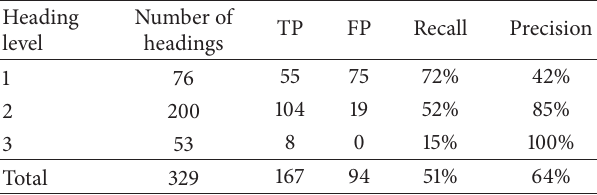
Table 4: Evaluation results for the heading-level assignment